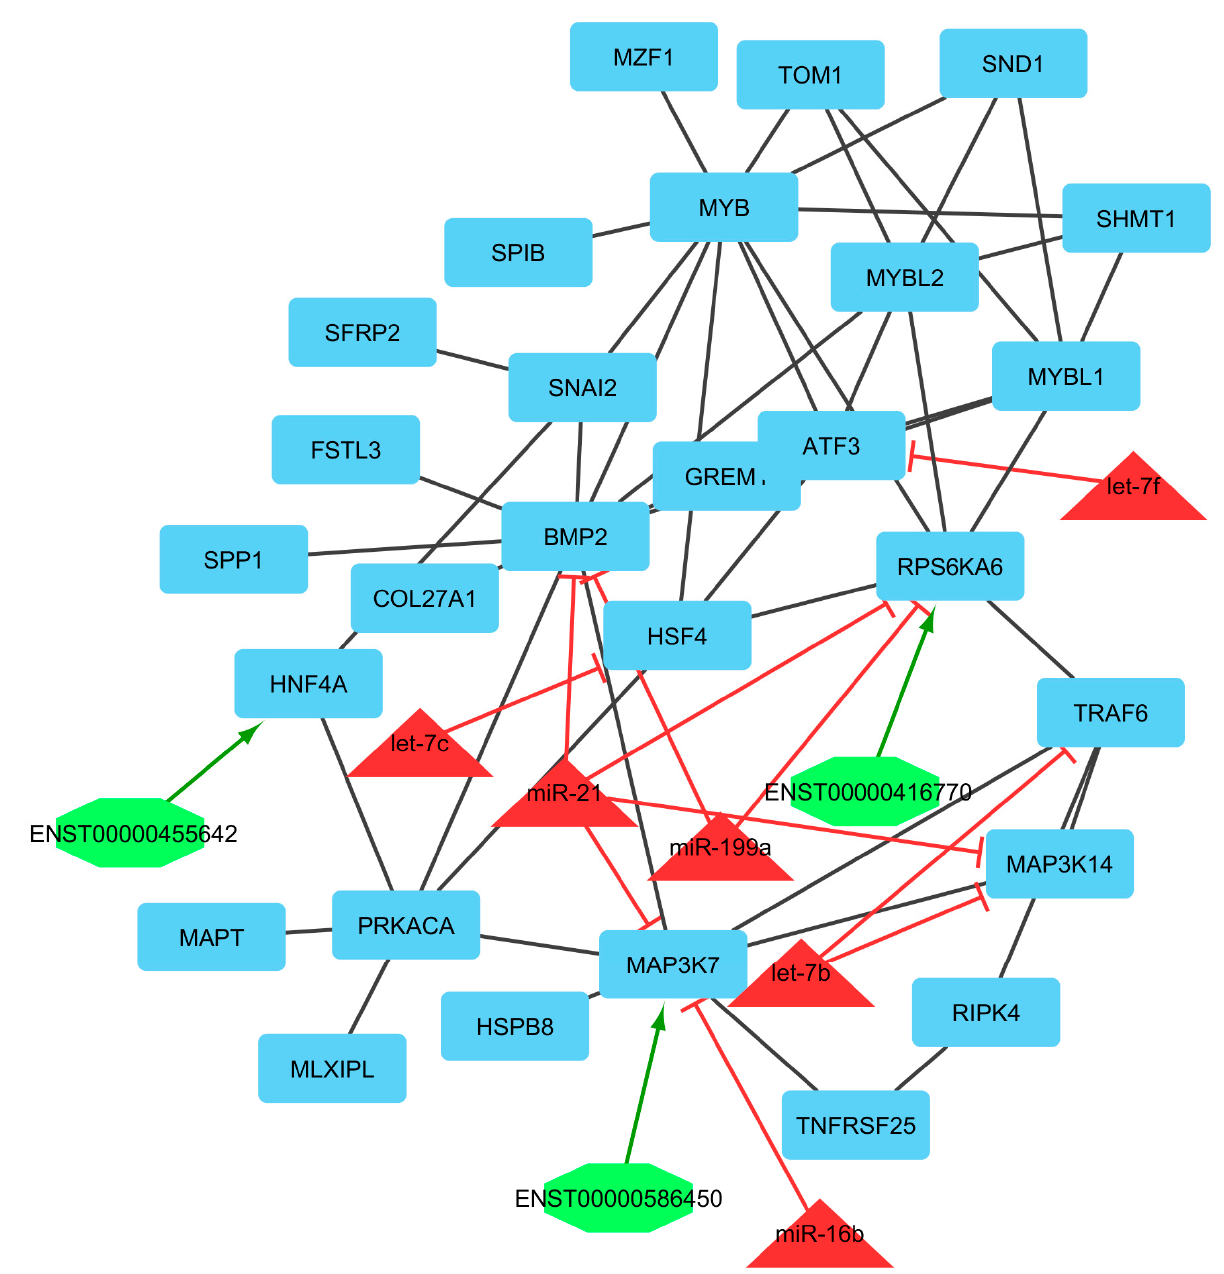
Figure 7. Module 4: 65 mRNAs/genes, 6 lncRNAs, and 7 miRNAs in an interacted network were identified. In this network, the quadrilateral nodes represent mRNAs/genes, octagonal nodes rep- resent lncRNAs, and triangle nodes represent miRNAs. Edges indicate the interactions; black edges represent mRNA–mRNA interactions, green edges represent lncRNA–mRNA interactions, and red edges represent miRNA–mRNA interactions.